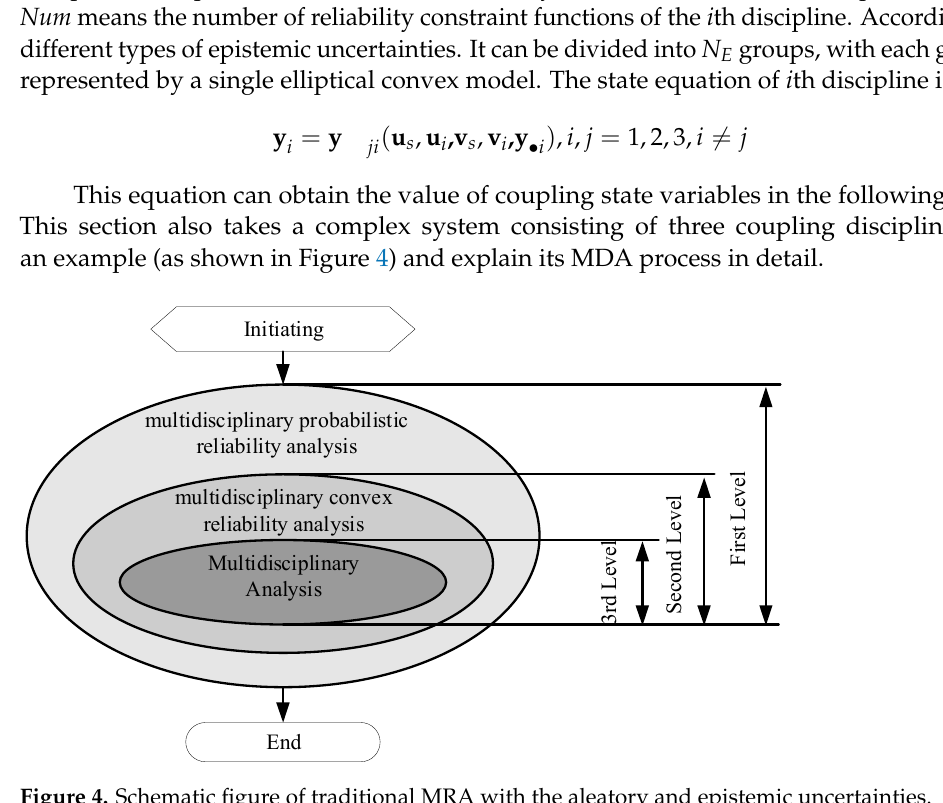
Figure 4. Schematic figure of traditional MRA with the aleatory and epistemic uncertainties. u s is the shared aleatory design variables of system input, and u 1 , u 2 and u 3 are aleatory variables of system input of discipline 1, discipline 2, and discipline 3 respectively; they are local aleatory independent variables. V s is the shared epistemic design variable of system input, and v 1 , v 2 and v 3 are the epistemic variables of system input of discipline 1, discipline 2 and discipline 3 respectively; they are local epistemic independent variables. y ij ( i ≠ j ) is the interdisciplinary coupling-state variables, representing the output of discipline i and the input of discipline j . z i ( i = 1, 2, 3) represents the output of discipline 1, discipline 2, and discipline 3. In particular, the aleatory variables in this paper refer to variables in line with a certain distribution, while the epistemic variables refer to those with interval uncertainties.